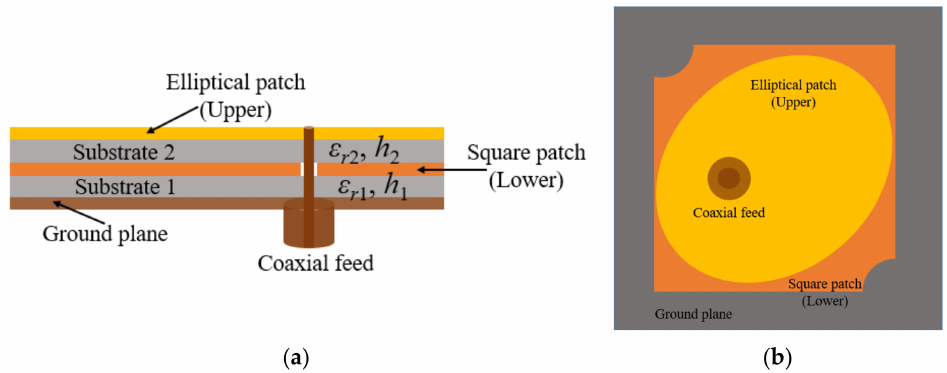
Figure 1. Schematic of the stacked antenna element ( a ) side view ( b ) top